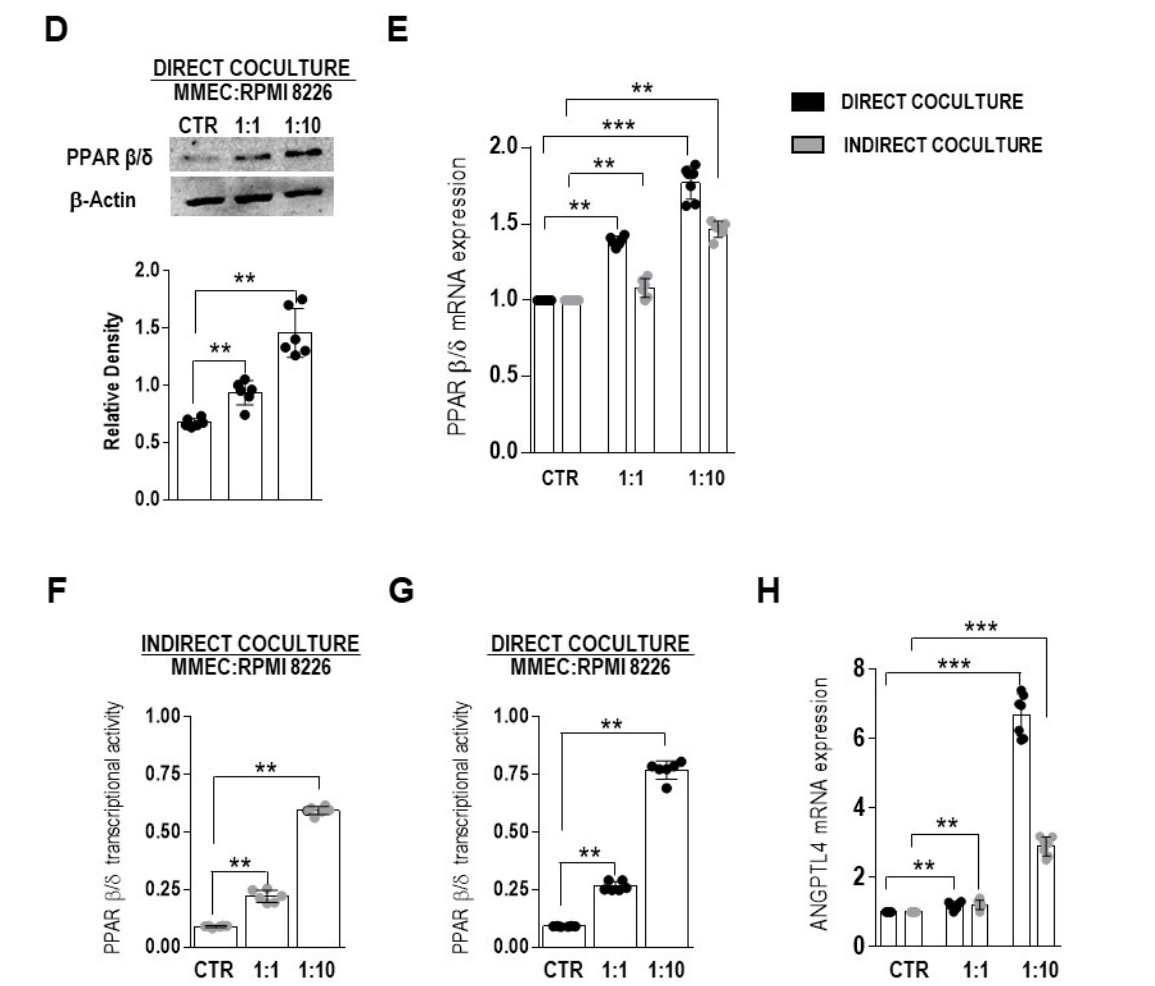
Figure 2. Impact of the bone marrow (BM) microenvironment on PPAR β / δ expression in BM endothelial cells from MM patients (MMEC). ( A , B ) MMEC were cultured for 24 h in culture medium (CTR) or culture medium conditioned by bone marrow mononuclear cells (BMMC) from ( A ) MGUS patients (MGUS BM medium) or ( B ) MM patients (MM BM medium). Western blots and densitometric analyses of PPAR β / δ expression in MMEC lysates normalized to β -actin. ( C – H ) MMEC were cultured for 24 h, either alone (CTR) or with RPMI 8226 cells at 1:1 and 1:10 cell ratios. The cells were separated (indirect co-culture) or not (direct co-culture) by Transwell membrane inserts. ( C , D ) Western blots and densitometric analysis of the expression of PPAR β / δ in MMEC (normalized to β -actin) under different culture conditions. ( E ) Relative PPAR β / δ mRNA levels in MMEC under different culture conditions. The values were normalized to those of the control and determined by real time-PCR and the 2 − ∆∆ Ct method. ( F , G ) PPAR β / δ transcriptional activity in MMEC under different culture conditions. ( H ) Relative ANGPTL4 mRNA levels in MMEC cultured alone (CTR) or